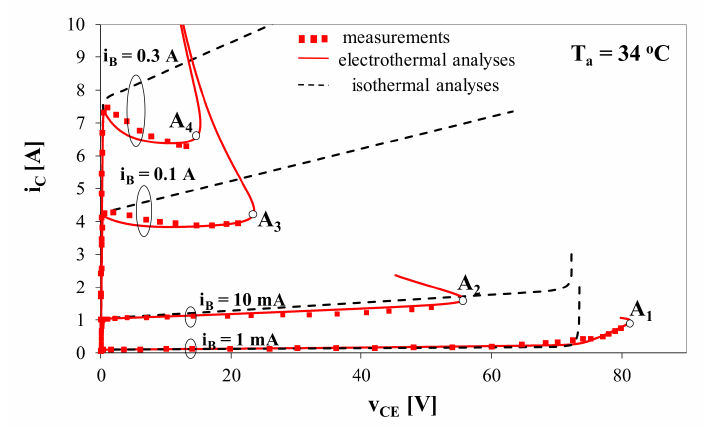
Figure 2. Output characteristics of the BJT of the type 2N3055. Values of currents and voltages corresponding to the points lying in non-isothermal characteristics were measured with the use of APPA 207 digital multimeters using the classical indirect method. The results of measurements were registered when the thermally steady state was obtained. All the measurements were performed only ones. Therefore, only type B evaluation of uncertainty is used. According to information given by the manufacturer [47], the relative uncertainty of the measured values is smaller than ± 0.2% for currents and ± 0.06% for voltages. In turn, isothermal characteristics were measured using the pulse method and a Keithley 2612A source-meter. The relative uncertainty of these measurements did not exceed ± 0.06% for currents and ± 0.02% for voltages [48].